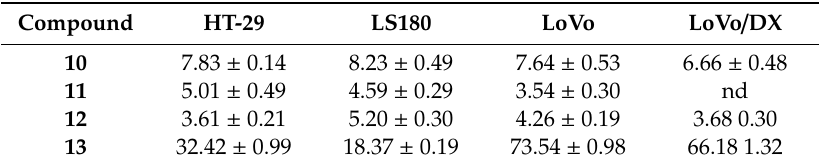
Table 8. IC 50 values of compounds 10 – 13 against the human colon cancer HT-29, LS180, LoVo, and LoVo/DX cell lines in µg/mL.